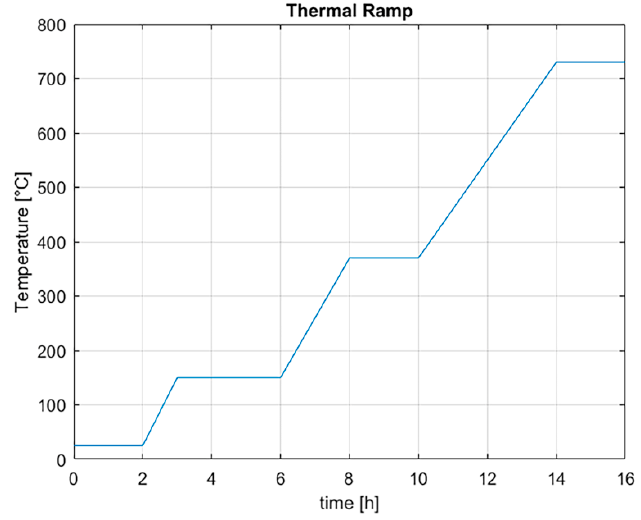
Figure 3. Thermal ramp to prepare the plaster for melting process.